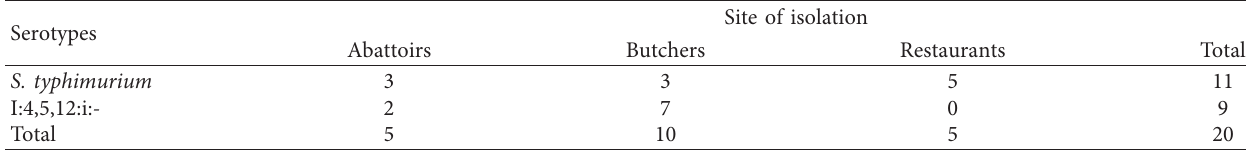
Table 2: Salmonella serotypes distribution and site of isolation.